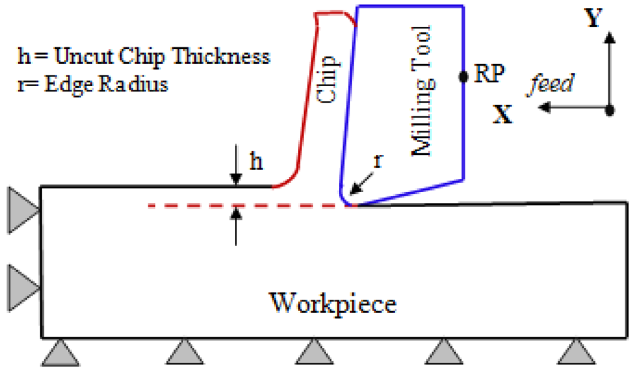
Fig. 1. Finite element model of micro end milling process.